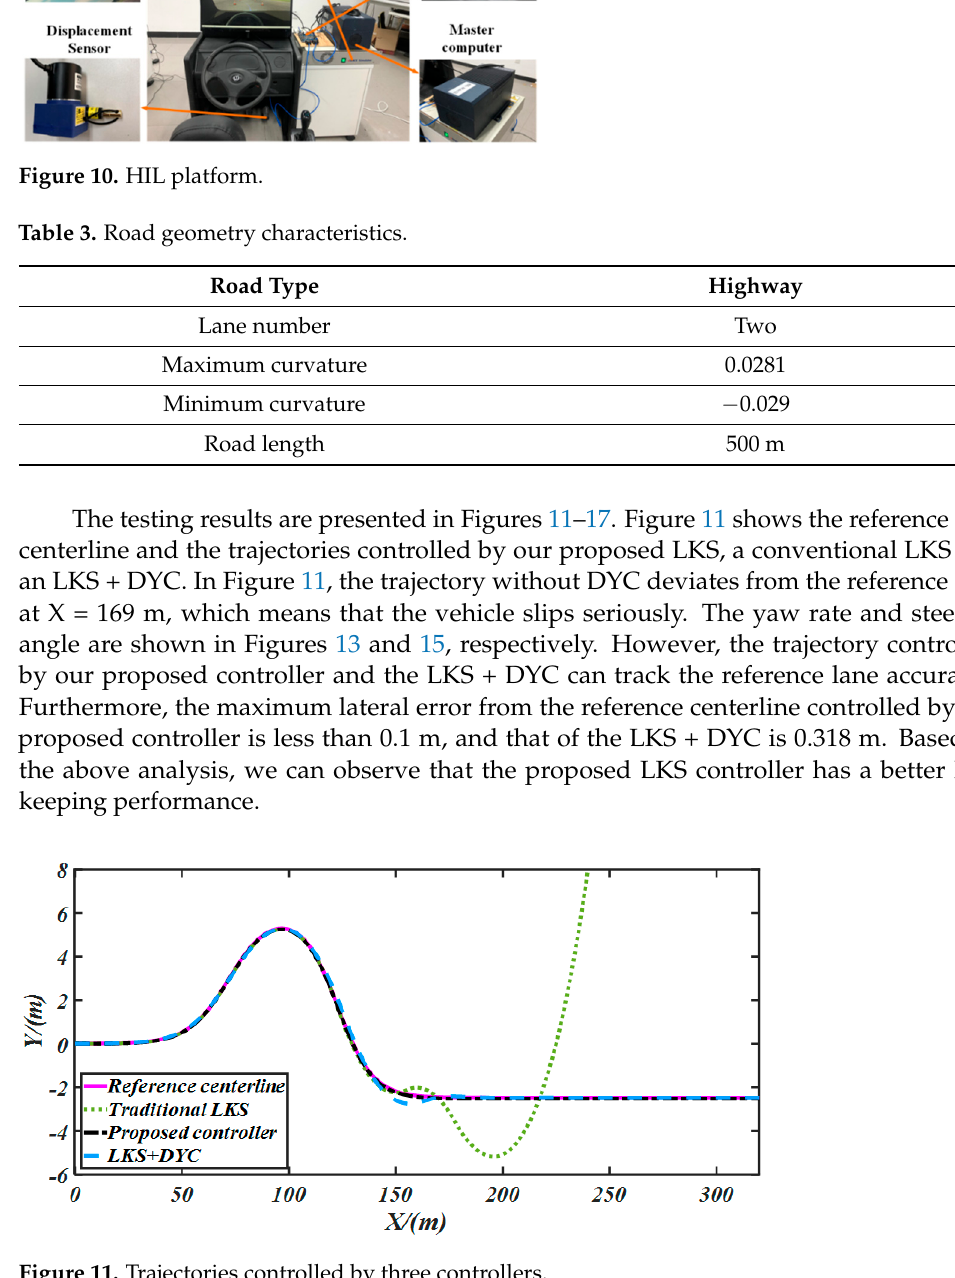
Table 3. Road geometry characteristics.